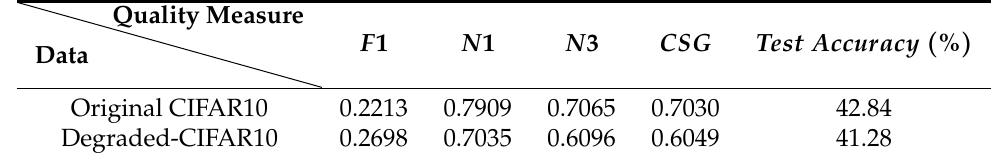
Table 8. Quality measures on the degraded-CIFAR10 dataset. The existing quality measures F 1, N 1, N 3, and CSG only capture the class separability and fail to capture the degradation. Lower values of N 1, N 3, and CSG represent higher class separability, whereas lower values of F 1 represent lower class separability. The test accuracy is from MLP-2 trained with original and degraded-CIFAR10, respectively, and tested on the original CIFAR10 test